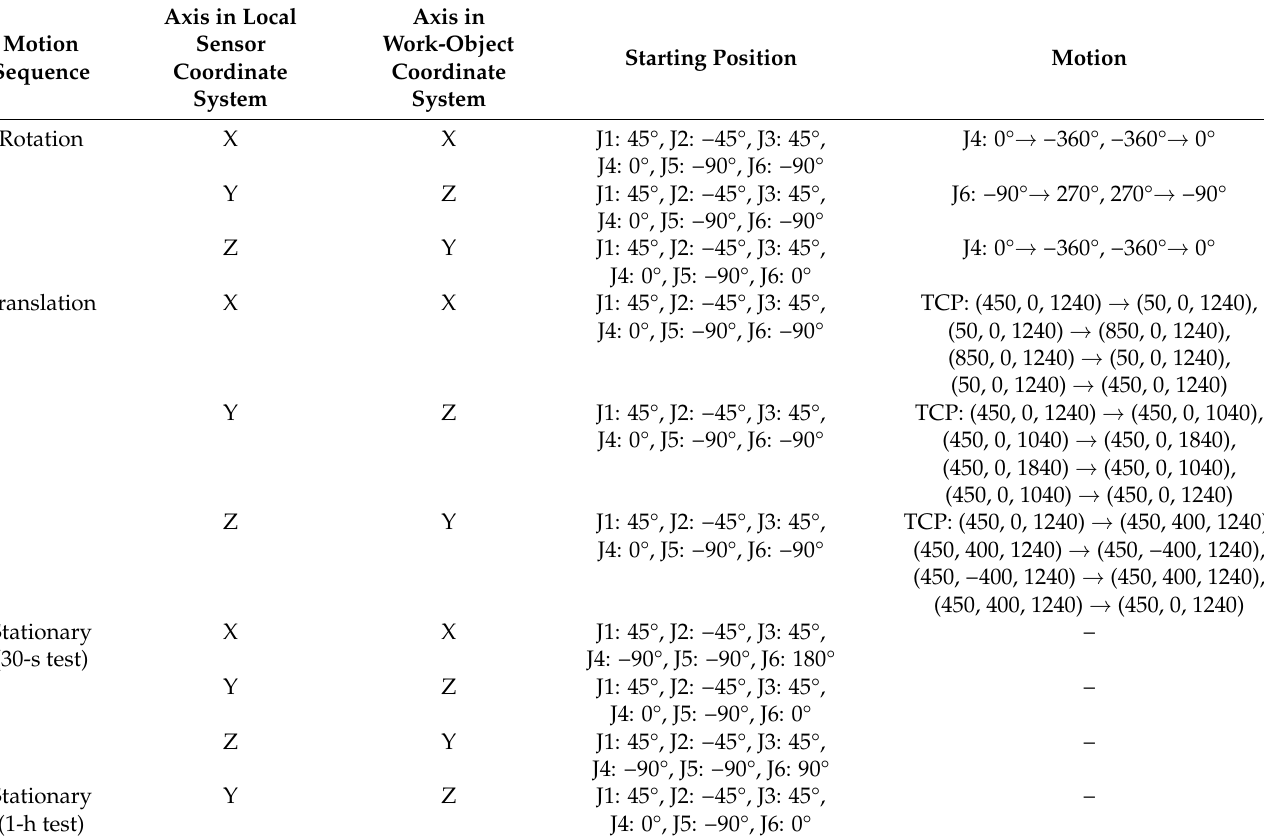
Table 2. Starting position and motion sequences for the IRB 2600 robot. Starting position is provided in joint coordinates for all six joints (J1, J2, J3, etc.). For rotations, the motion is described by the rotation of the individual joints. For translations, the motion is described by the location of the tool center point (TCP) in mm in a work-object coordinate system which is rotated 45° around the vertical Z-axis compared to the robot’s default base coordinate system. The TCP is a projected point 103 mm away from the robot mounting plate in a direction normal to the robot mounting